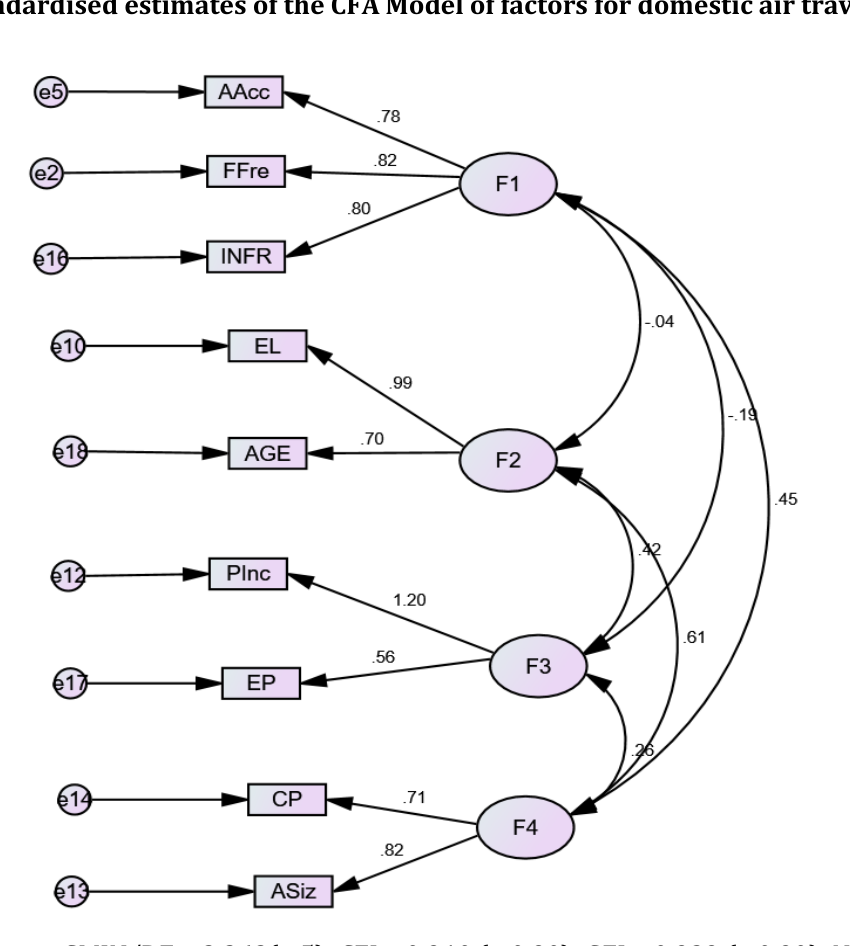
Figure 3. Standardised estimates of the CFA Model of factors for domestic air travel at